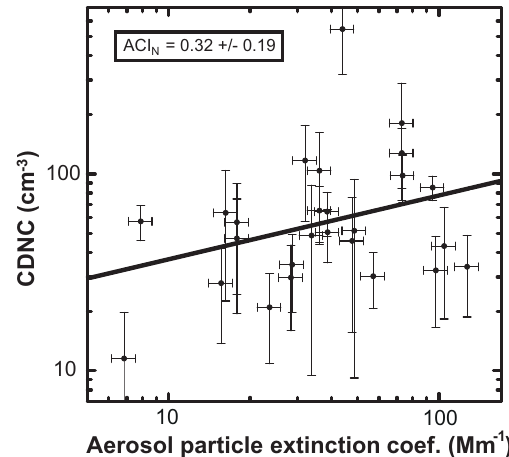
Figure 3. Cloud droplet number concentration (CDNC, for the 30– 70m layer above cloud base) vs. aerosol particle extinction coef- ficient (mean value for the layer from 300 to 1000m below cloud base) for 26 dual-FOV Raman lidar probings. The linear regression of the data yields ACI N = 0 . 32 ± 0 . 19 (slope of the black line). In- formation of up- and downdraft periods is not considered in this analysis. Error bars show the retrieval